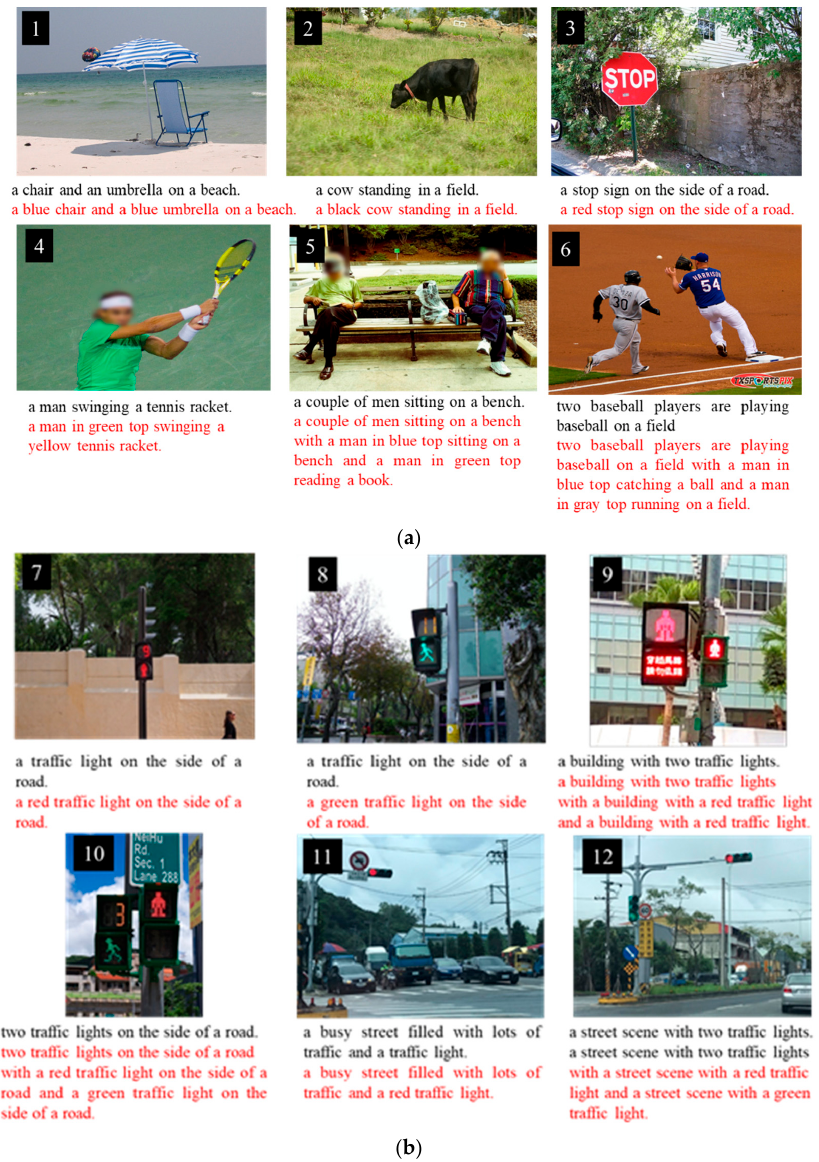
Figure 20. Examples of captions generated by the traditional image captioning algorithm (in black) and by the proposed model (in red). ( a ) First set of images ; ( b ) second set of images